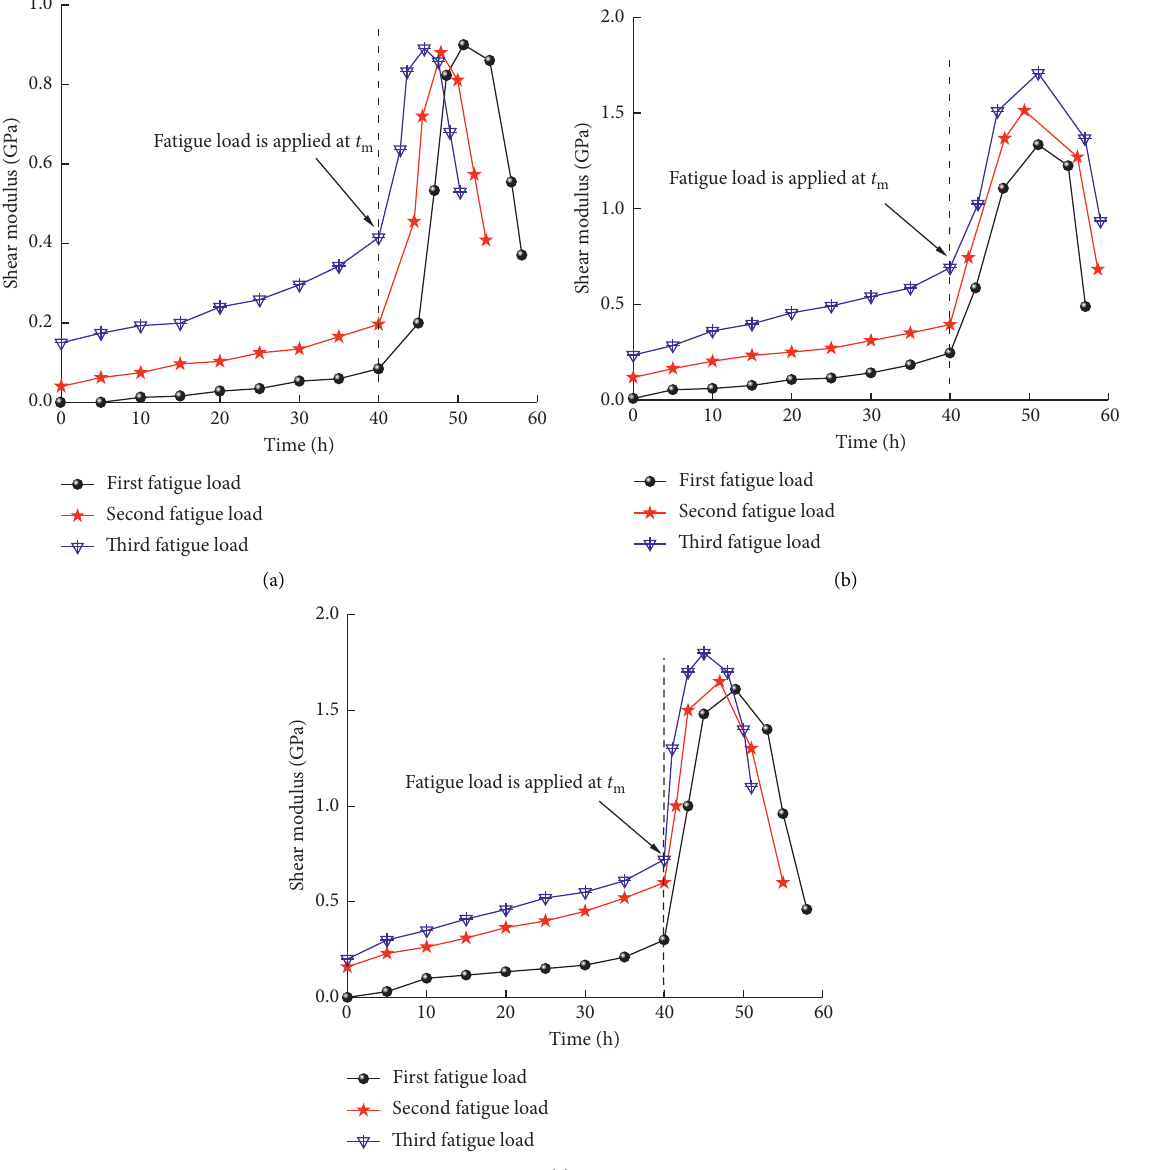
Figure 8: Shear modulus versus time curve. (a) Anchored sandstone rock masses. (b) Anchored marble rock masses. (c) Anchored granite rock